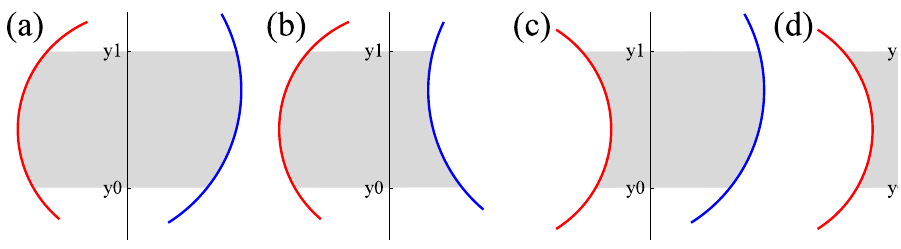
Fig 4. Four scenarios in which a gray solvent patch is surrounded by two circle segments and two sweep